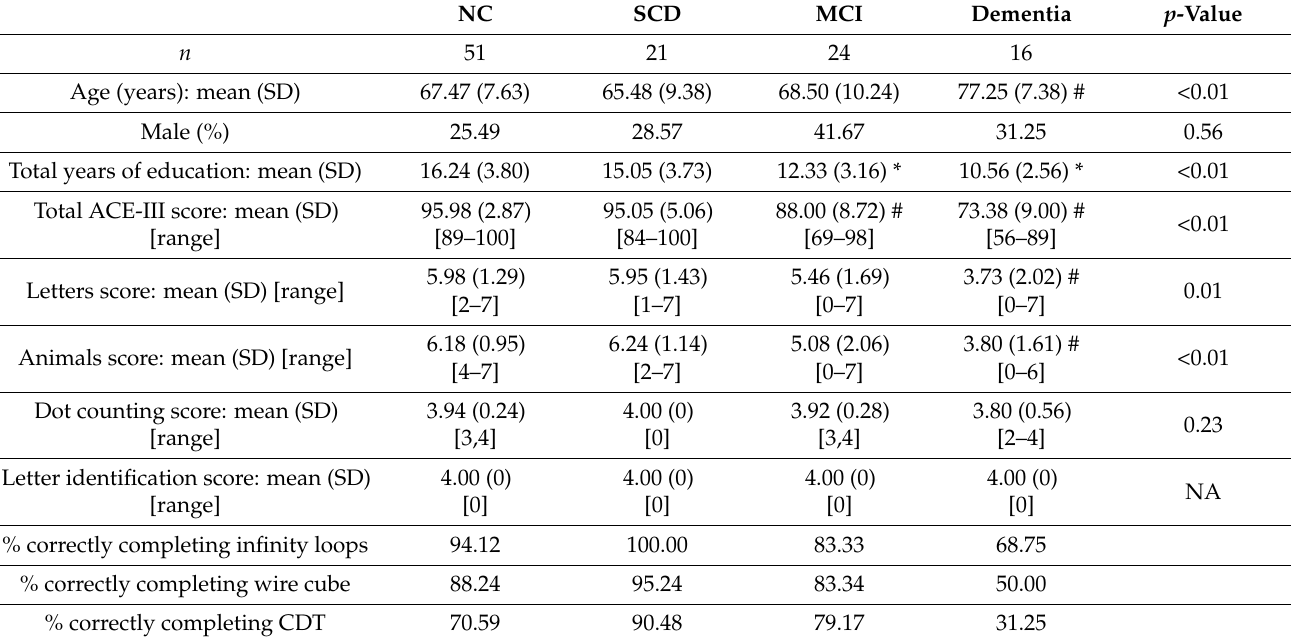
Table 1. Clinical and demographic characteristics of each cognitive diagnosis group. NC is normal controls; SCD, subjective cognitive decline; MCI, mild cognitive impairment; ACE-III, Addenbrookes Cognitive Examination- III; CDT, clock drawing task; letters, verbal fluency test 1; animals, verbal fluency test 2; dot counting, visuospatial test 4; letter identification, visuospatial test 5. p -values represent the main effect of group and between-group differences as shown with the following symbols: # p < 0.05 significant difference in comparison with all other groups; * p < 0.05 significant difference in comparison with